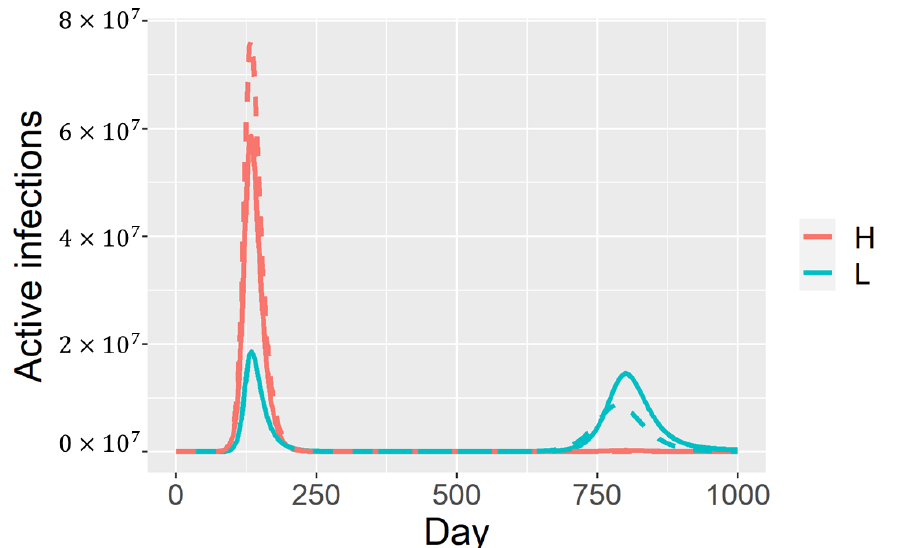
Figure 2. Partial immunity and a dose response can promote avirulence.The initial outbreak consists mainly of high-shedding cases, but these are replaced by low-shedding cases in subsequent outbreaks. The dashed curve corresponds to the approximate dynamics described in the text. Solid curves are model solutions under the parametrization (cid:101) = 0.01, where Q ah = (cid:101) and Q al = Q kl = Q kh = (cid:103) Q a h = (cid:103) Q a l = (cid:103) Q k h = (cid:103) Q k l = 1 − (cid:101)